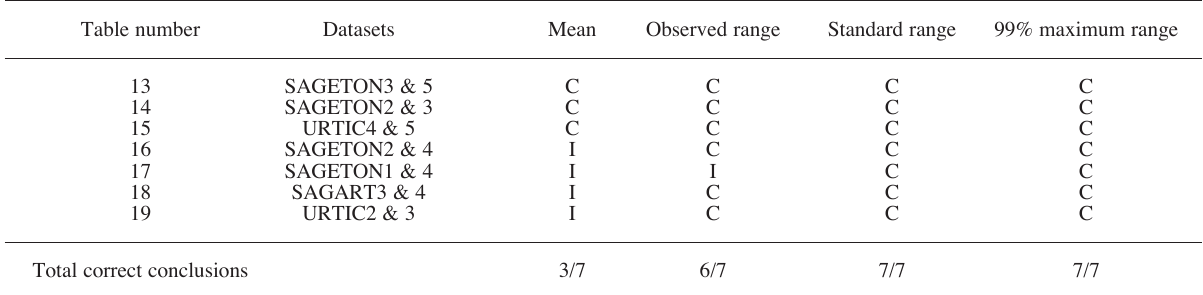
Datasets Mean Observed range Standard